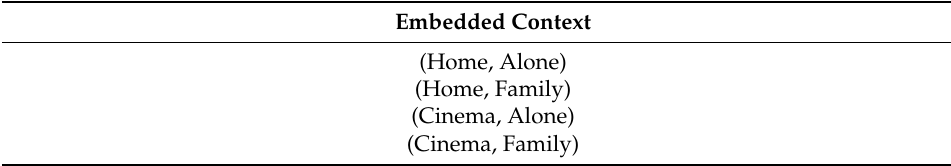
Table 3. List of Embedded Contexts based on contextual information of Table 1.